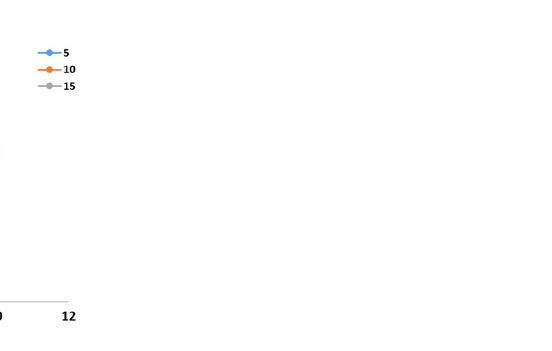
Figure 8. Effect of pH at 5, 10, and 15 °C on the pectinase production by Cladosporium chlamydosporigenum AUMC